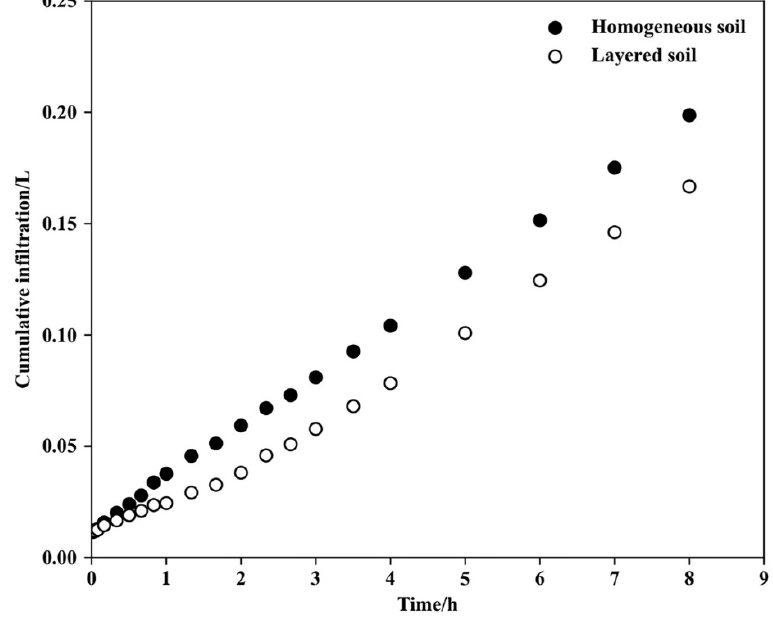
Figure 5. Evolution of cumulative infiltration.